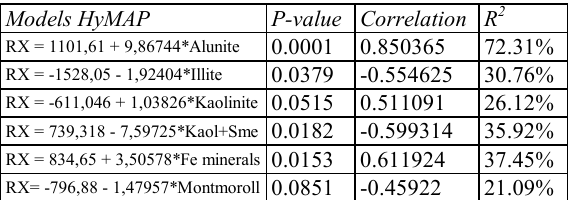
Table 1. Comparison of relationships between spectral anomalies and hydrothermal alteration, from HyMAP images.